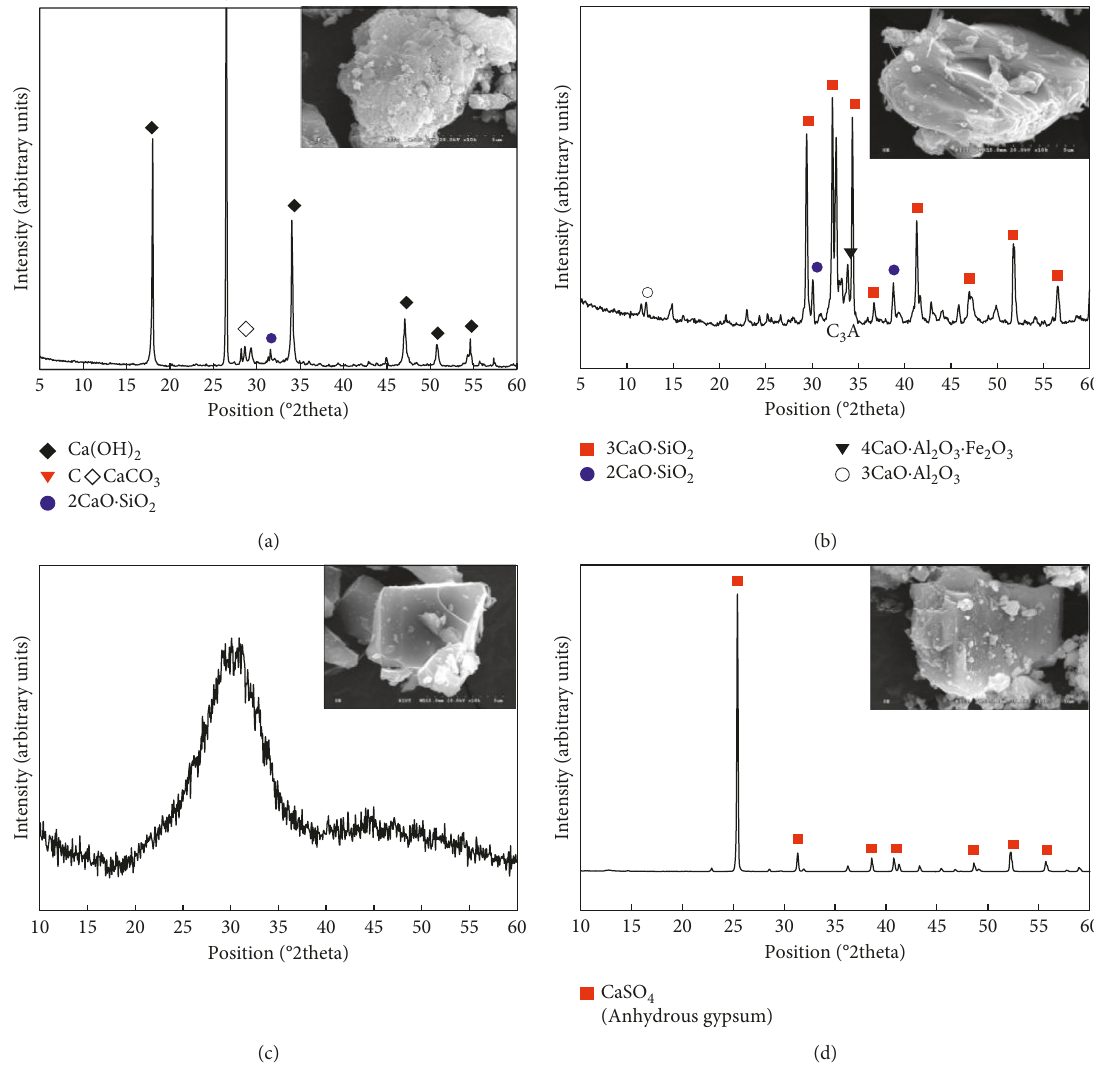
Figure 1: XRD patterns and SEM image of used materials. (a) DS, (b) OPC, (c) BFS, and (d)